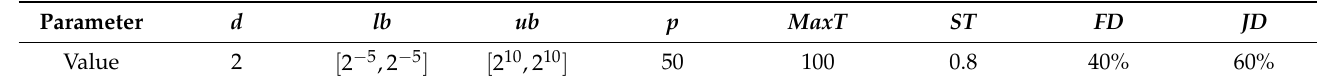
Table 5. SSA-related parameters in SSA-SVR.